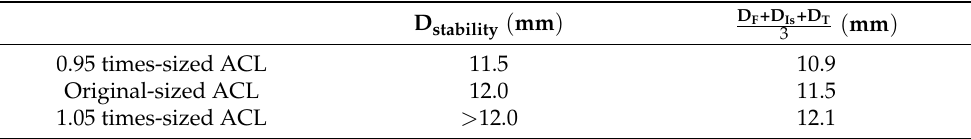
Table 4. The graft diameter (D stability , in mm) required to restore graft force and knee stability in anterior tibial translation (ATT), internal tibial rotation (ITR) and valgus tibial rotation (VTR), and the average values of effective diameters ( D F + D Is + D T , in mm) of the femoral and tibial insertion sites and 3 isthmus of the native